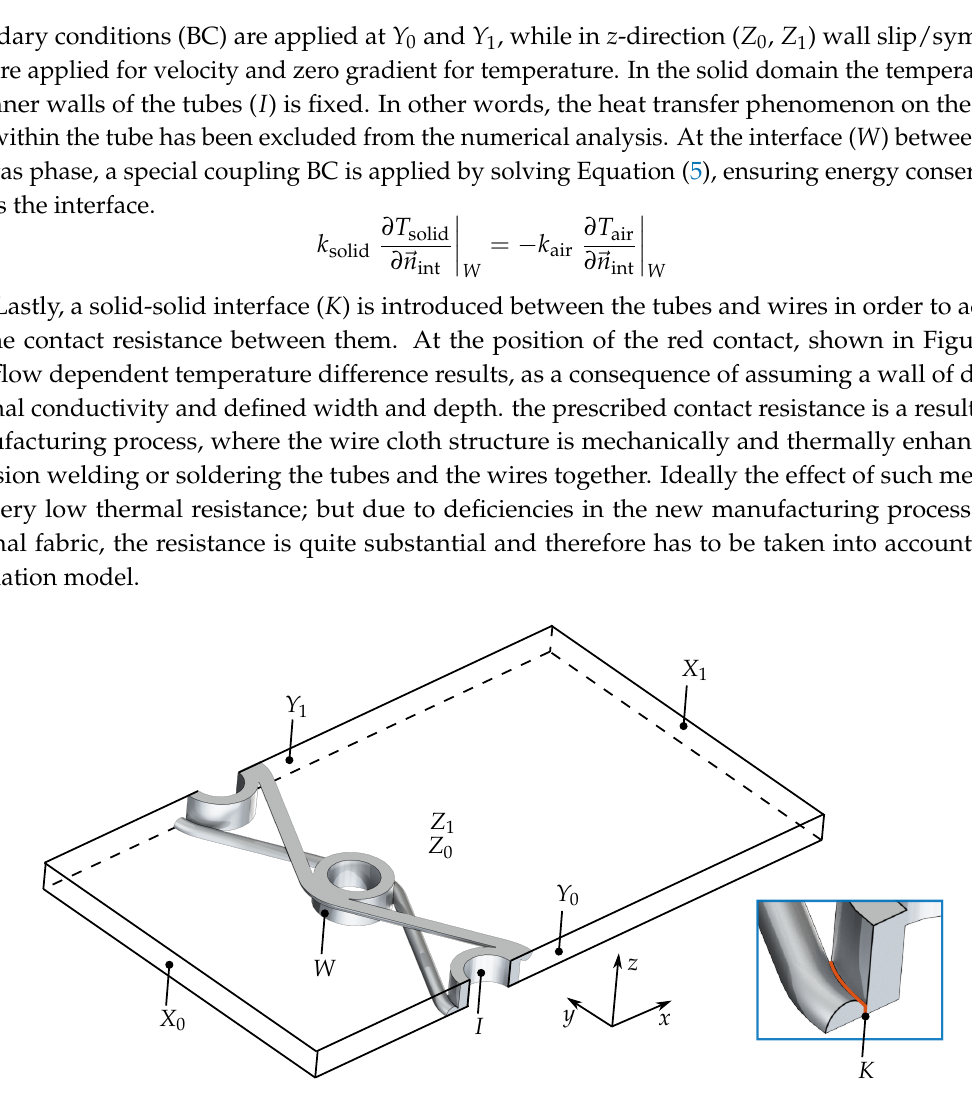
Figure 3. Schematic of the simulation area. Fabric inside fluid domain with boundaries (X, Y, Z). Contact resistance (K), interface between solid and fluid region (W) and inner wall of the tubes (I) define the boundaries of the fabric.